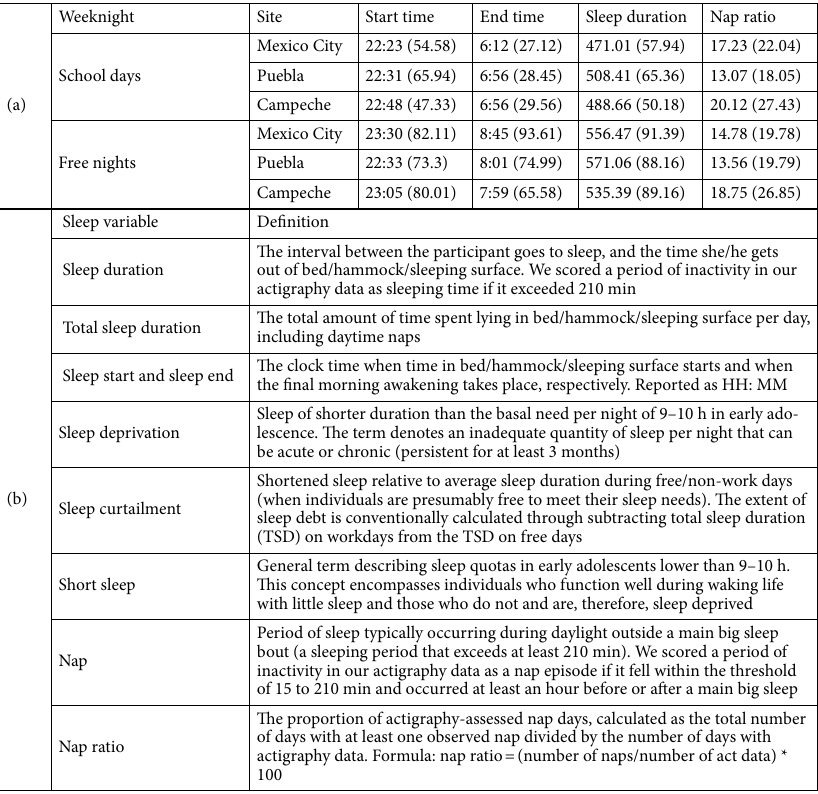
(Table 5) incorporates pubertal development, gender, napping before the main sleep at night, ambient light at night, clear sky conditions, and assisted awakening as predictor variables for the sleep duration variance